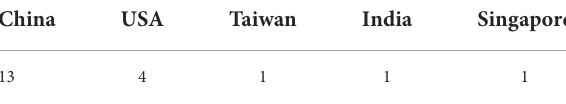
TABLE 3 Nationality of principal